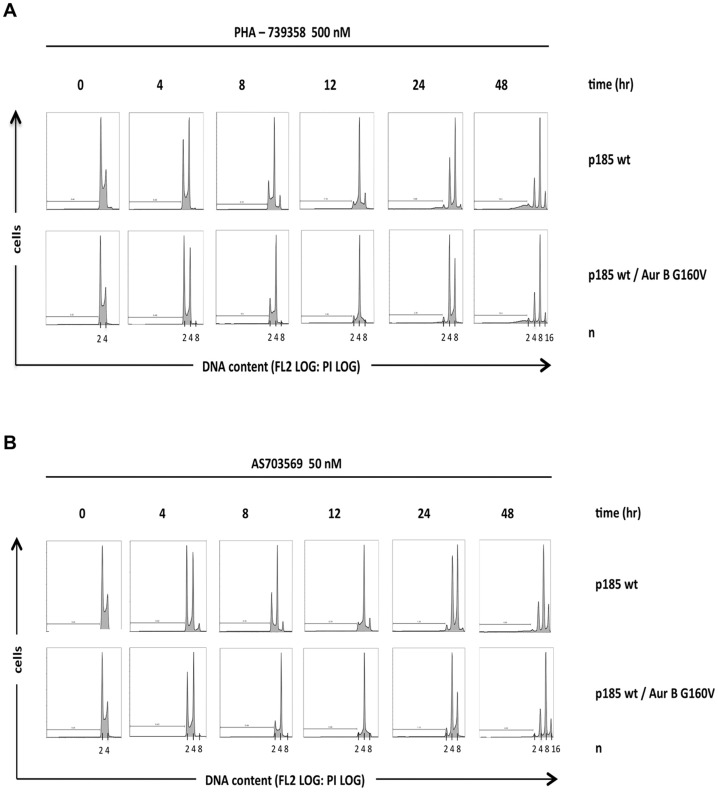
Expression of the resistant Aurora B G160V mutant partly rescues cell division failures after exposure to PHA-739358 and R763/AS703569.Ba/F3 p185 wt and Aur B G160V expressing Ba/F3 p185 wt cells were cultured in the presence of 500 nM PHA-739358 (A) or 50 nM R763/AS703569 (B), harvested at the indicated time points and analysed by flow cytometry to determine DNA content of propodium iodide (PI) stained cells.